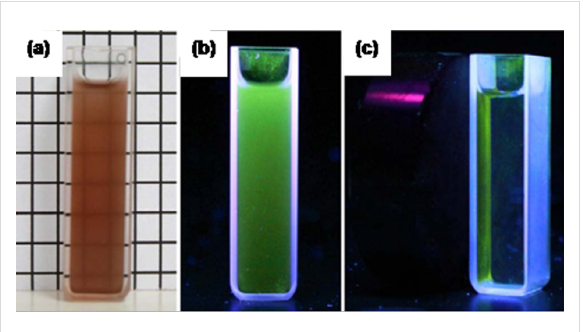
Figure 3: Magnetic and luminescent properties of core–shell-type hybrid NPs, Fe 3 O 4 @CeF 3 :10%Tb 3+ /SiO 2 , (a,b) before and (c) after magnetic capture, and (a) before and (b,c) during UV irradiation ( λ = 254 nm). Reproduced with permission from [26]. Copyright 2011